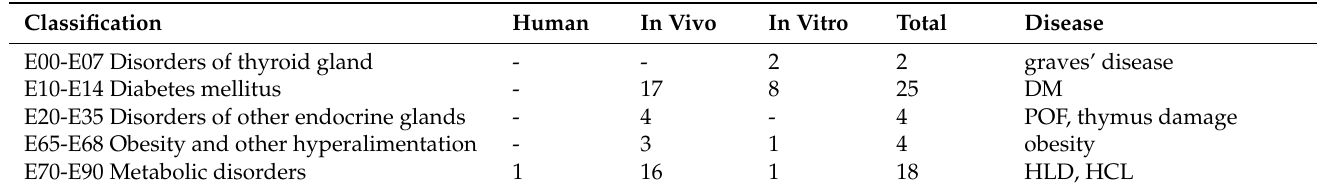
Table 7. The statistics of pharmacological results and its major diseases of SMC by experimental type in IV Endocrine, nutritional, and metabolic diseases of